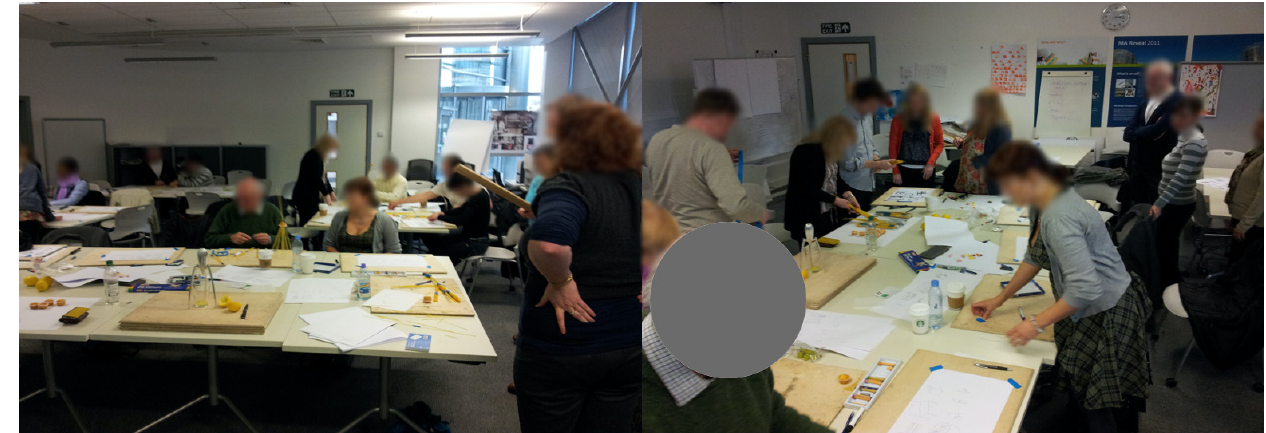
Figure 1. Early disruptive design workshops with carers.